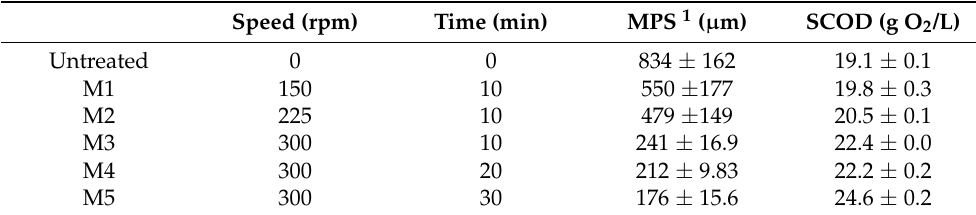
Table 3. Mean particle sizes of food waste depending on pretreatment